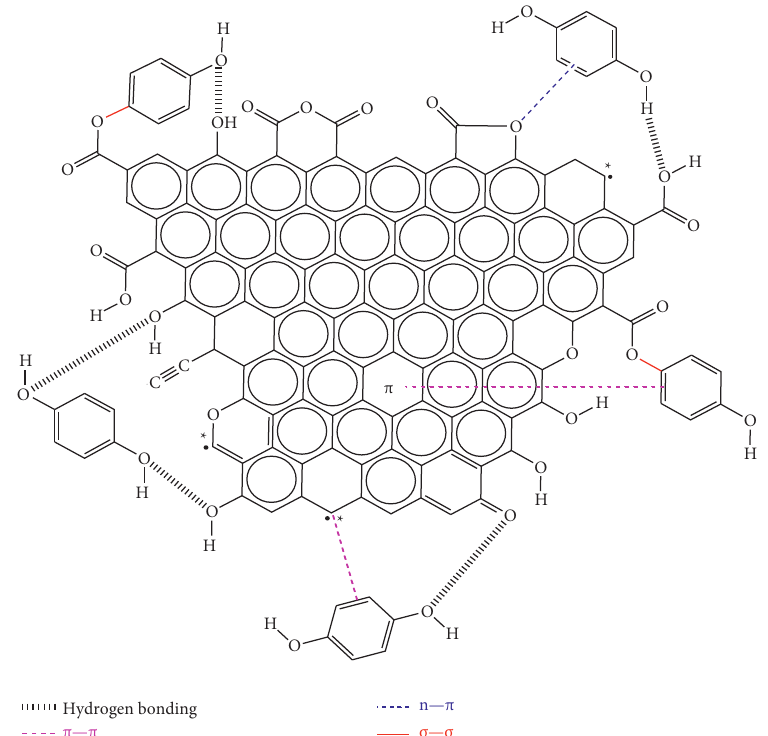
Figure 12: Possible interactions contributing to the mechanism of hydroquinone adsorption on CAK-S except pore Table 12: Comparison of CAK-S with other materials for HQ and R reduction. Adsorbent